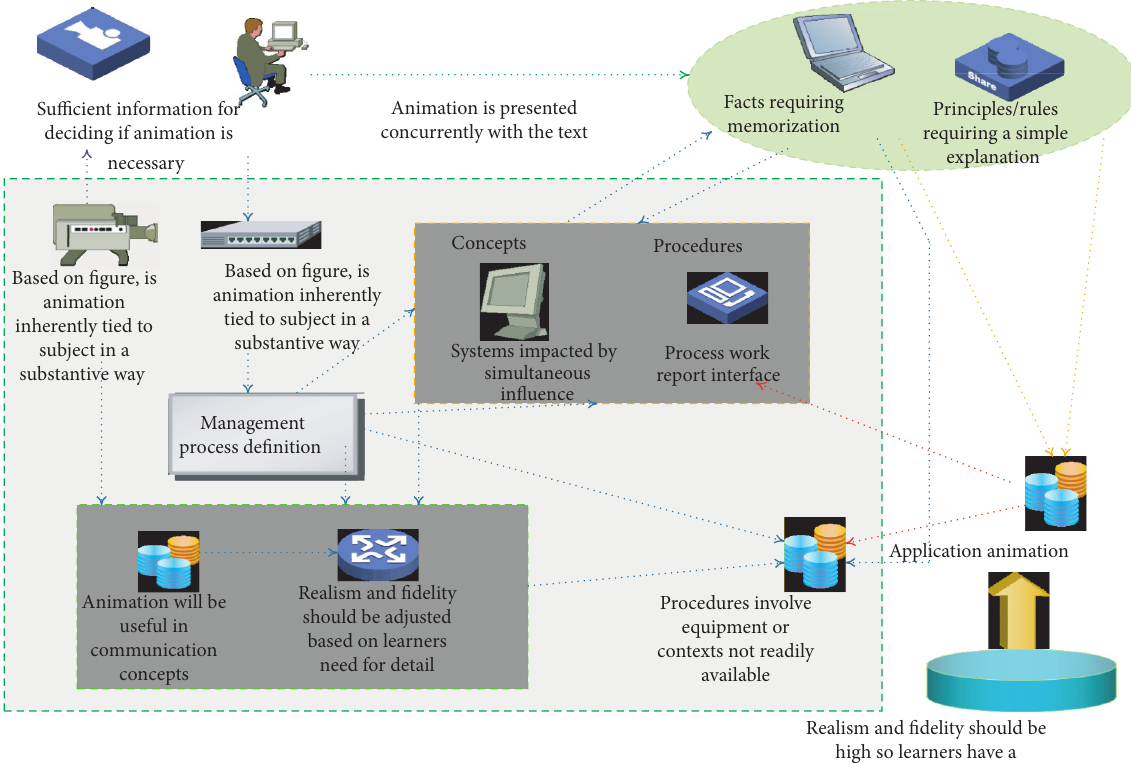
Figure 2: The structure of the animation space information